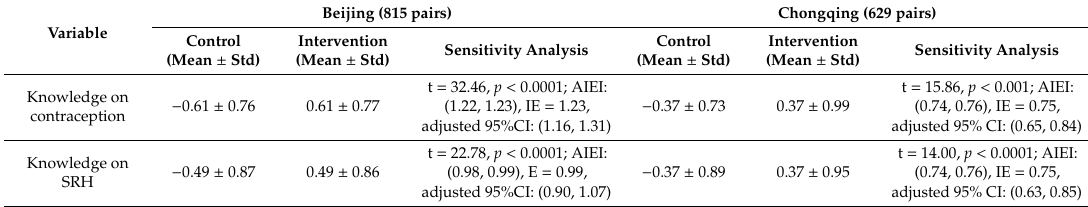
Table 2. E ff ects of the intervention on the knowledge among